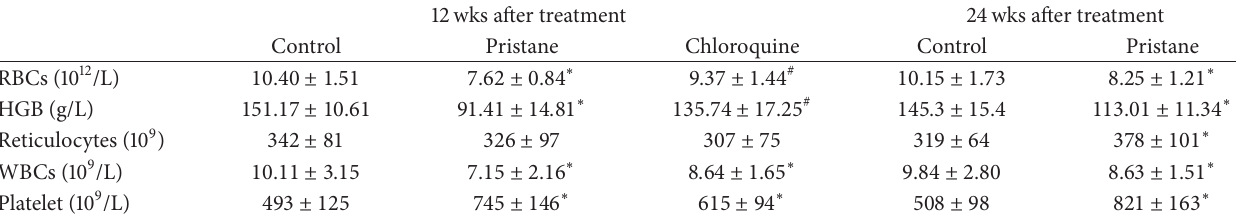
Table 2: Hematological parameters.